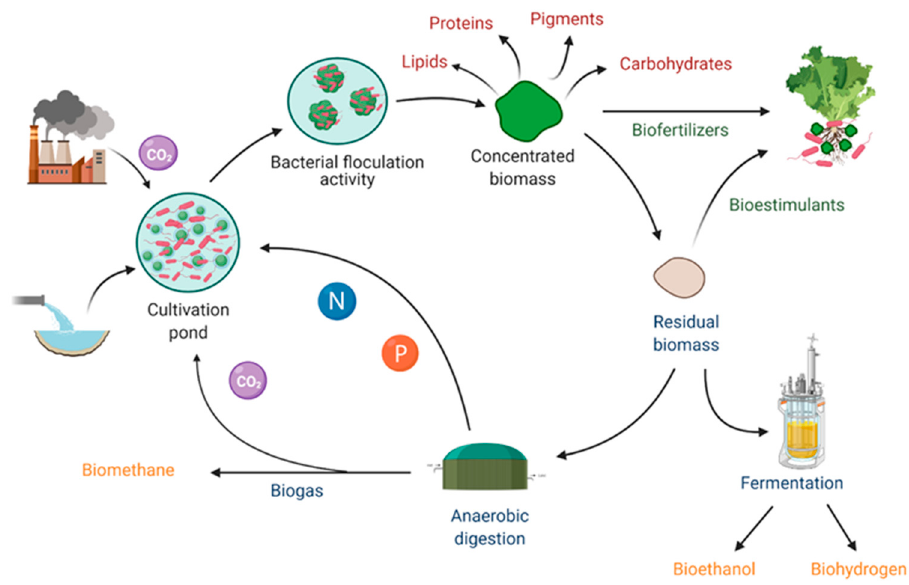
Figure 3. Schematic representation of the possible routes intended for microalgae–bacteria co-cultures in the biorefinery scenario. With the scale-up cultivation of these algae/bacteria consortia, there are many possible applications, e.g., the production of high-value-added compounds, reduction of CO 2 emissions, and by the reuse of biomass the production of bio-fertilizers, water bio-sanitation, production of alternative and sustainable energies. Reprinted with permission from González-González et al. (2021). Toward the Enhancement of Microalgal Metabolite Production through Microalgae–Bacteria Consortia. Biology [93]. Copyright (2021) MDPI.